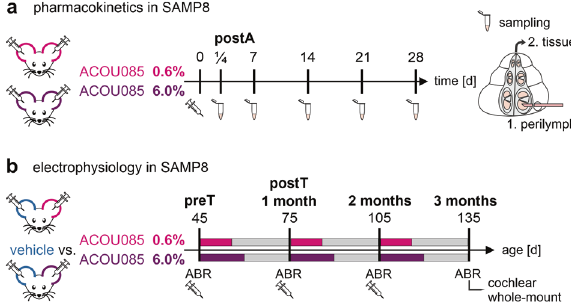
Fig. 1 Schematic representation of the pharmacokinetic and electrophysiology study design. a Schematic representation of the pharmacokinetic study design. Cochlear perilymph and tissue were sampled after a single administration of 0.6% or 6.0% w/v ACOU085 formulation via transtympanic injection into both ears of SAMP8 mice. Samples were collected for the timepoints 0.25, 7, 14, 21, and 28 days post-administration (postA). Concentrations of ACOU085 in cochlear perilymph and tissue were determined by liquid chroma- tography and mass spectrometry. b Schematic representation of the electrophysiology study design. The effect of repeated unilateral administrations via transtympanic injection of ACOU085 versus contralateral vehicle control was investigated in the SAMP8 mouse model for two dose groups, 0.6% or 6.0% w/v ACOU085, in a within- subject design. Auditory function was assessed at 1-month intervals from the age of 45 days (pre-treatment, preT) to 135 days (3-months post-treatment, postT) by determining auditory brainstem